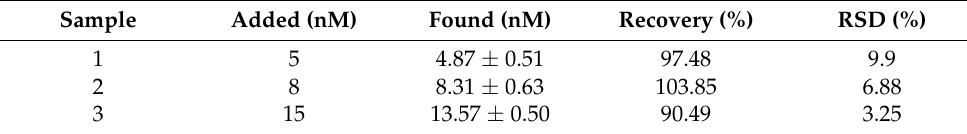
Table 2. Recovery experiments of SA in human serum samples (n = 3).